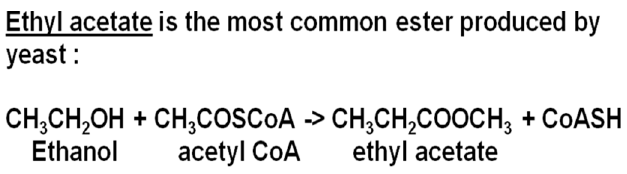
Figure 8. Production of ethyl acetate during fermentation.